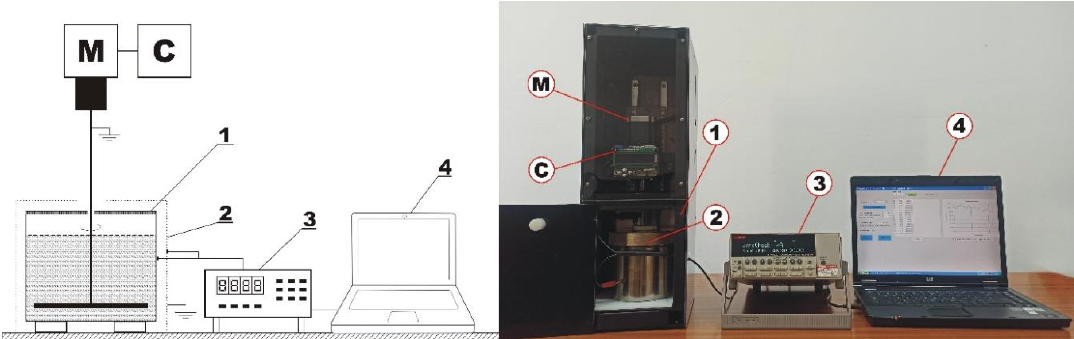
Figure 1. Rotating disc system for the investigation of electrification current of insulation liquids: 1—measuring vessel with liquid and disc, 2—Faraday cage, 3—Keithley 6517A electrometer, 4—portable computer, M—stepper motor and C—controller with display.